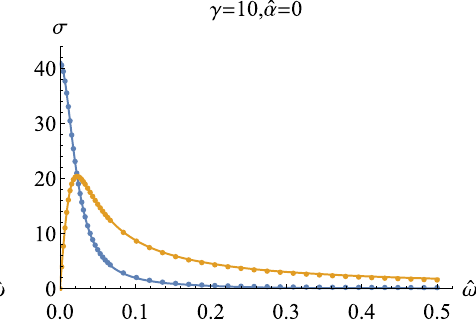
The right plot is fitted by the standard Drude formula. (For interpretation of the references to color in this figure, the reader is referred to the web version of this